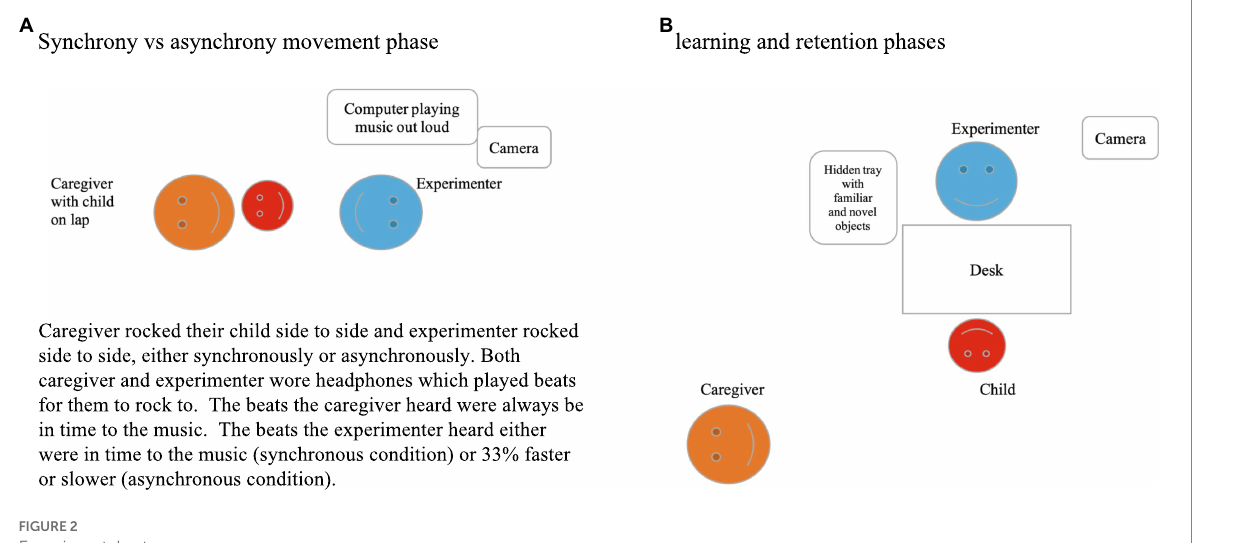
FIGURE 2 Experimental